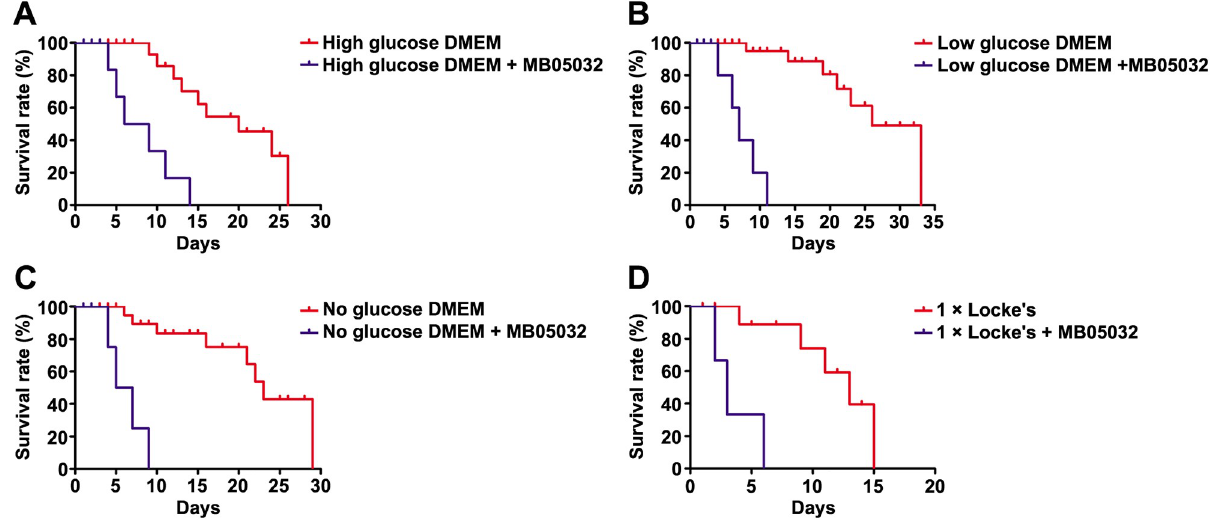
Fig 9. Survival curve of C . sinensis adults with or without MB05032 treatment. Adult flukes were respectively maintained on high, low, and no glucose DMEM (A, B, and C), as well as 1 × Locke’s (D) with or without the addition of MB05032. Survival curve of adult flukes was constructed using Kaplan-Meier analysis with the log-rank